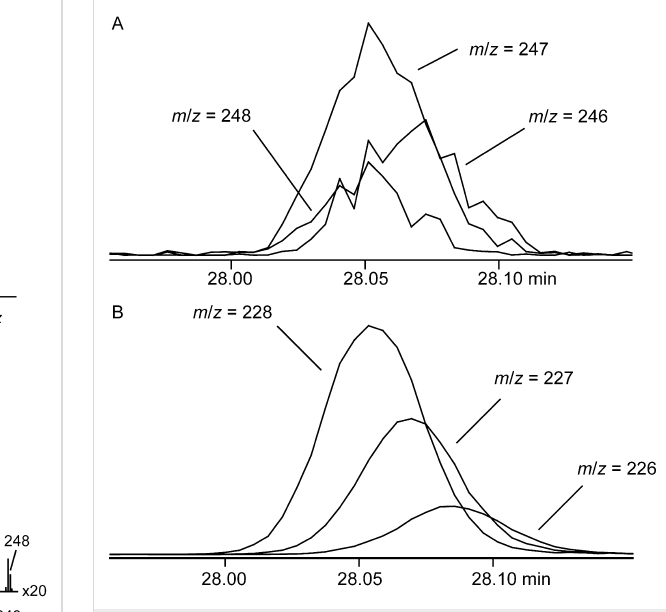
Figure 4: Ion chromatograms of fully deuterated 3 for (A) the molecular ion ( m / z = 248, 247, and 246), and (B) the fragment ion arising by neutral loss of water ( m / z = 228, 227, and